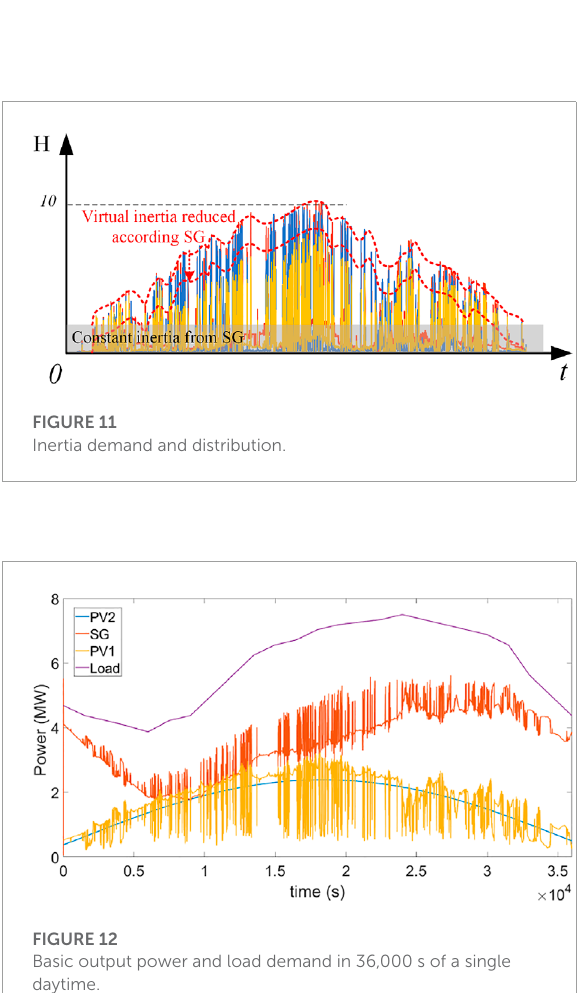
FIGURE 12 Basic output power and load demand in 36,000 s of a single